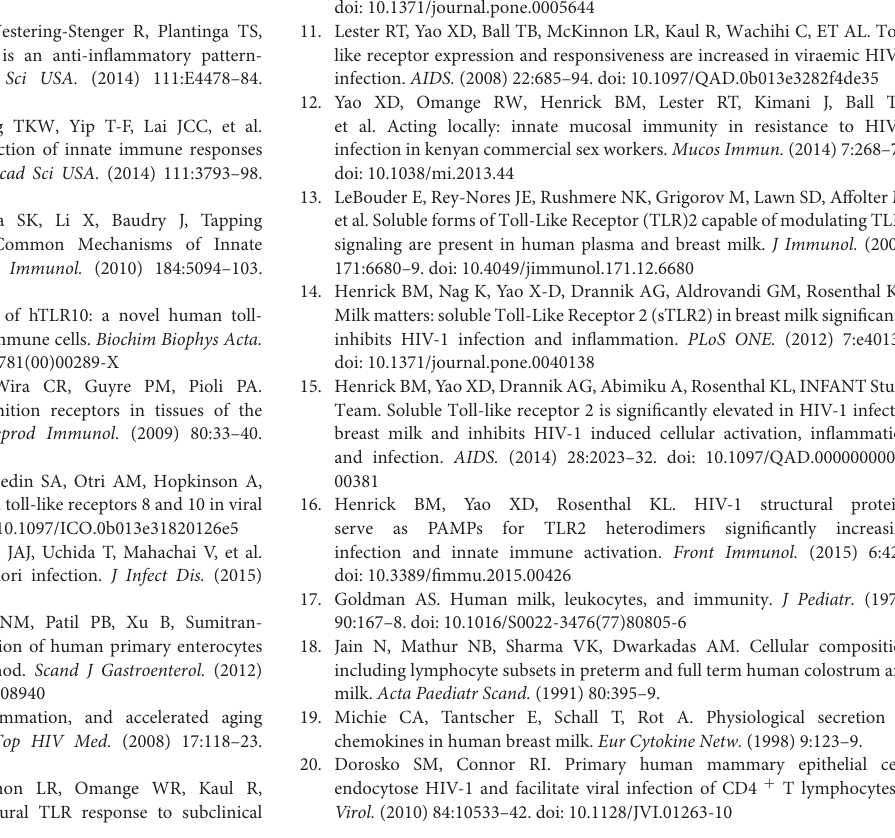
Supplementary Figure 1 | Confirmation of the siRNA mediated knockdown of TLR2, TLR10, TLR1, and TLR4 in THP-1 cells by Western blot. THP1 cells were either transfected with the specific siRNA targeting the respective TLRs or with a scrambled control. Lysates were prepared after 48h and subjected to Western blot analysis using the indicated